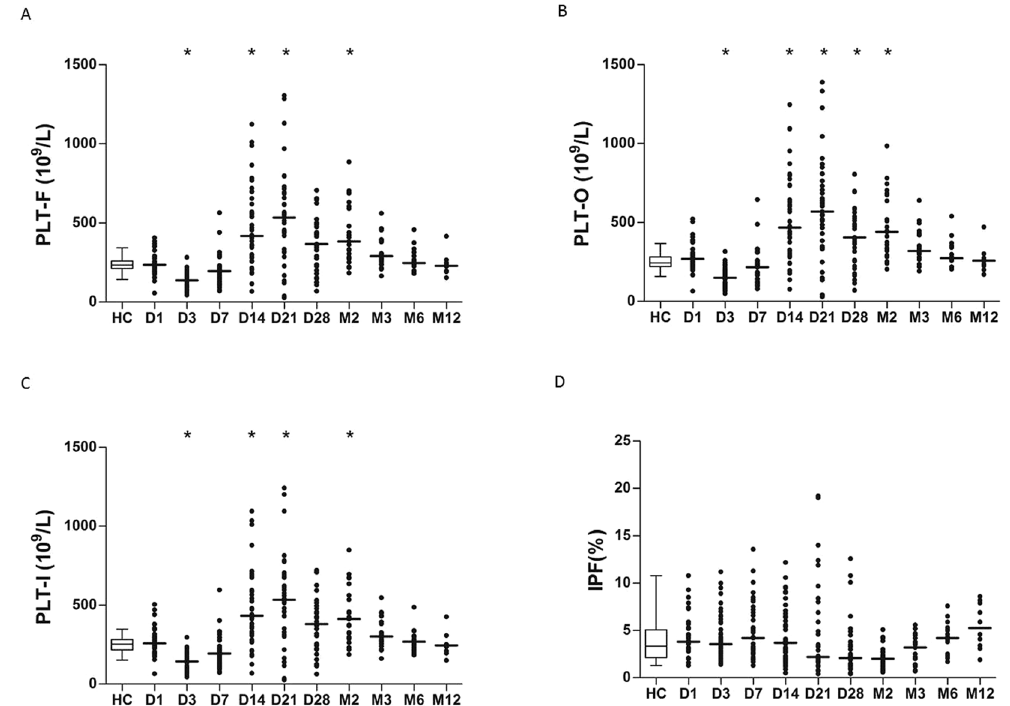
Figure 1. Thermal injury results in a dynamic platelet kinetic profile. ( A ) Platelet fluorescence count (PLT-F) across time (n = 39). ( B ) Platelet optical count (PLT-O) across time (n = 39). ( C ) Platelet impedance count (PLT-I) across time (n = 39). ( D ) Immature platelet fraction (IPF%) across time (n = 39). Differences in kinetics were compared to data from control cohort (n = 40) using a Mann-Whitney test; * p <